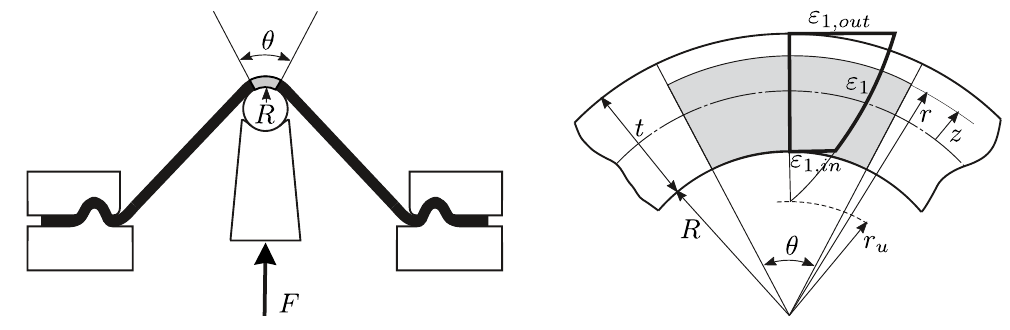
Figure 3. Variables in a deformed sheet